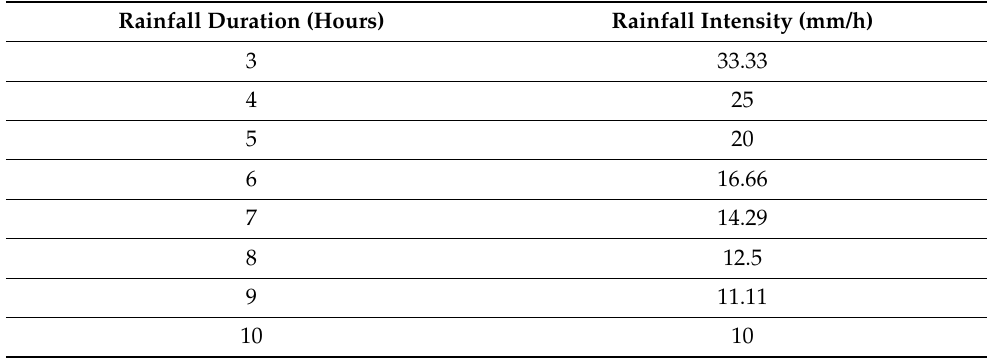
Table 2. Overview of the rainfall characteristics of the synthetic rainfall events. Total rainfall amounts up to 100 mm of precipitation for all events. Rainfall Duration